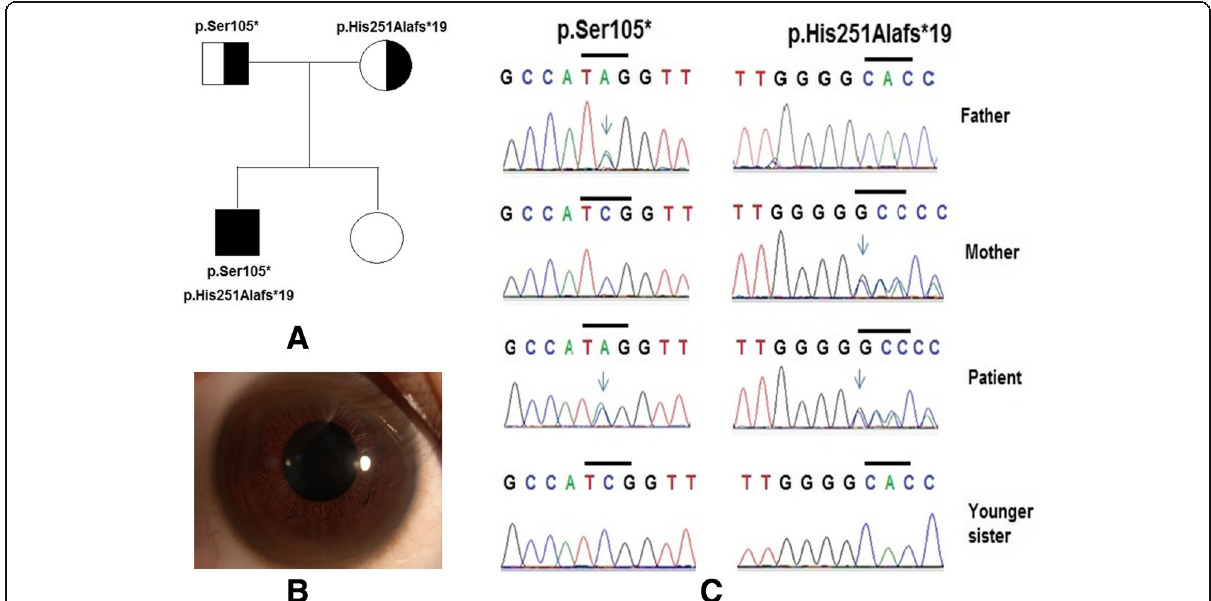
Fig. 2 Mutations of the ATP7B gene were identified by sequencing in patient 2 and his family. Pedigree of patient ’ s family ( a ), the Kayser-Fleischer ring around the cornea of patient ’ s eye ( b ) and mutations ( c ) of ATP7B gene were identified, including a compound heterozygous mutation p.Ser105* and heterozygous frameshift mutation p.His251Alafs*19